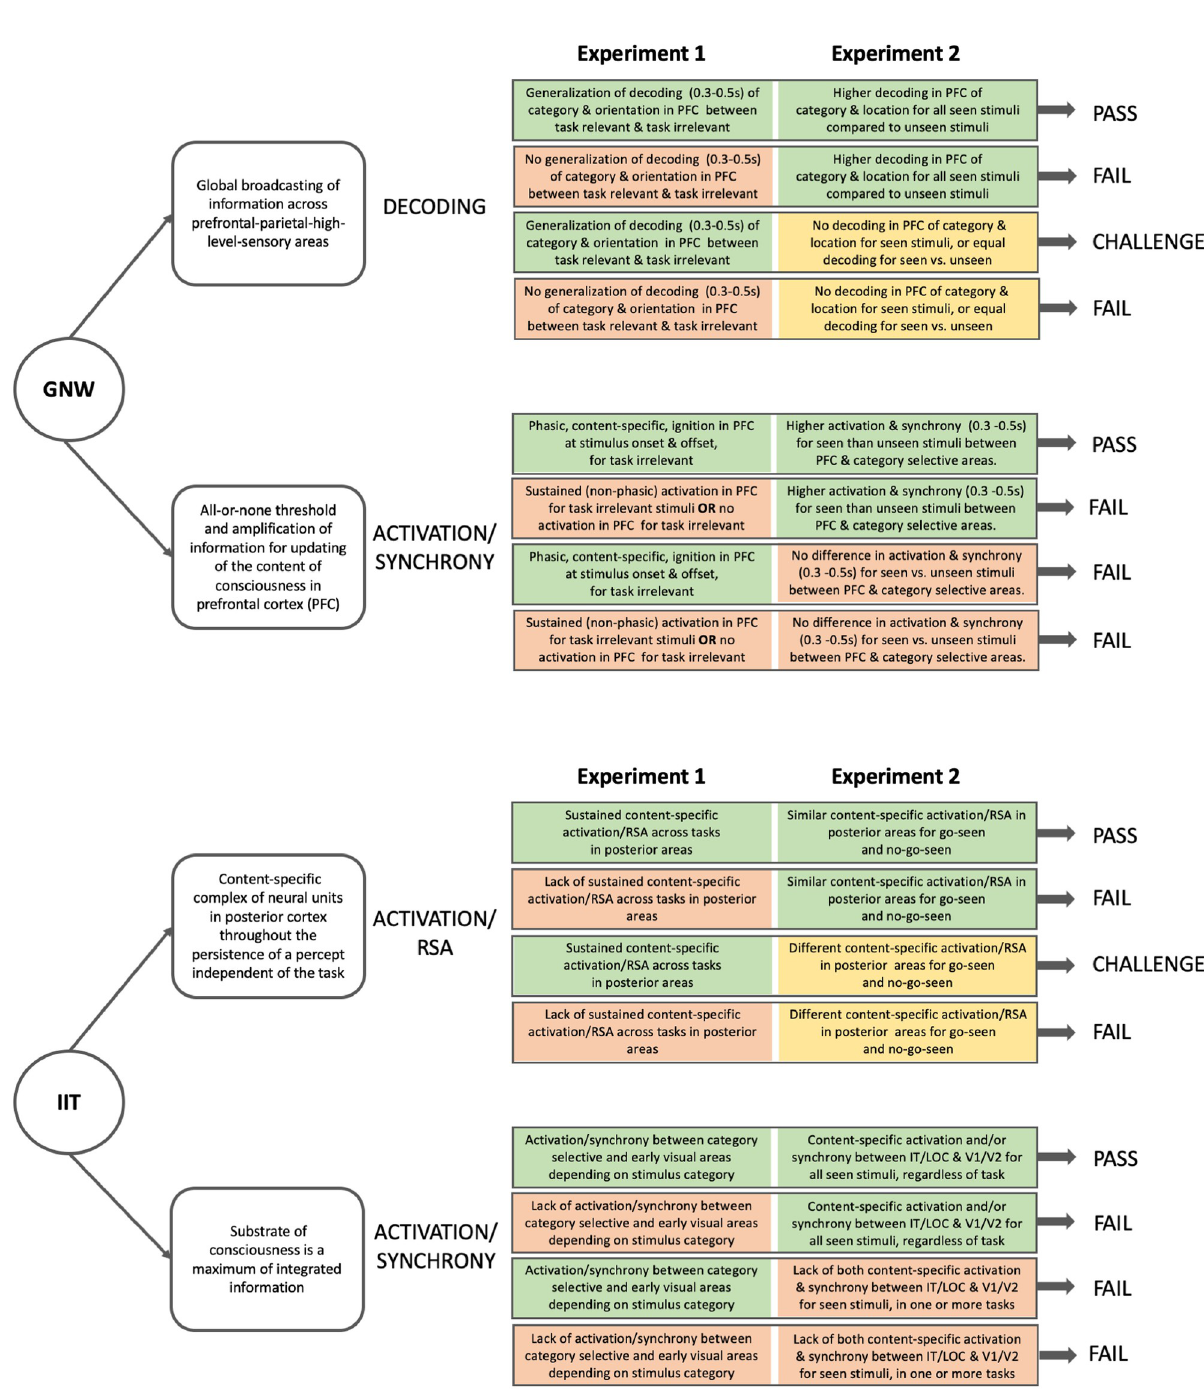
Fig 1. Core predictions, analyses, and potential results for the two experiments. For each theory (white circles), the core predictions (white rectangles) and possible outcomes (colored rectangles) are summarized. Green squares denote positive outcomes, red ones denote negative outcomes, and yellow squares denote negative outcomes that are less conclusive, as they might stem from limitations of the methods or analyses. On the right, we conclude how combinations of results would reflect on the theories. Note that some predictions require time-resolved measures (M-EEG, iEEG), while others can be tested with all three techniques. PFC refers to Prefrontal cortex; RSA refers to representational similarity analysis [RSA; 48]; IT refers to inferotemporal cortex; LOC refers to lateral occipital cortex; V1 refers to primary visual